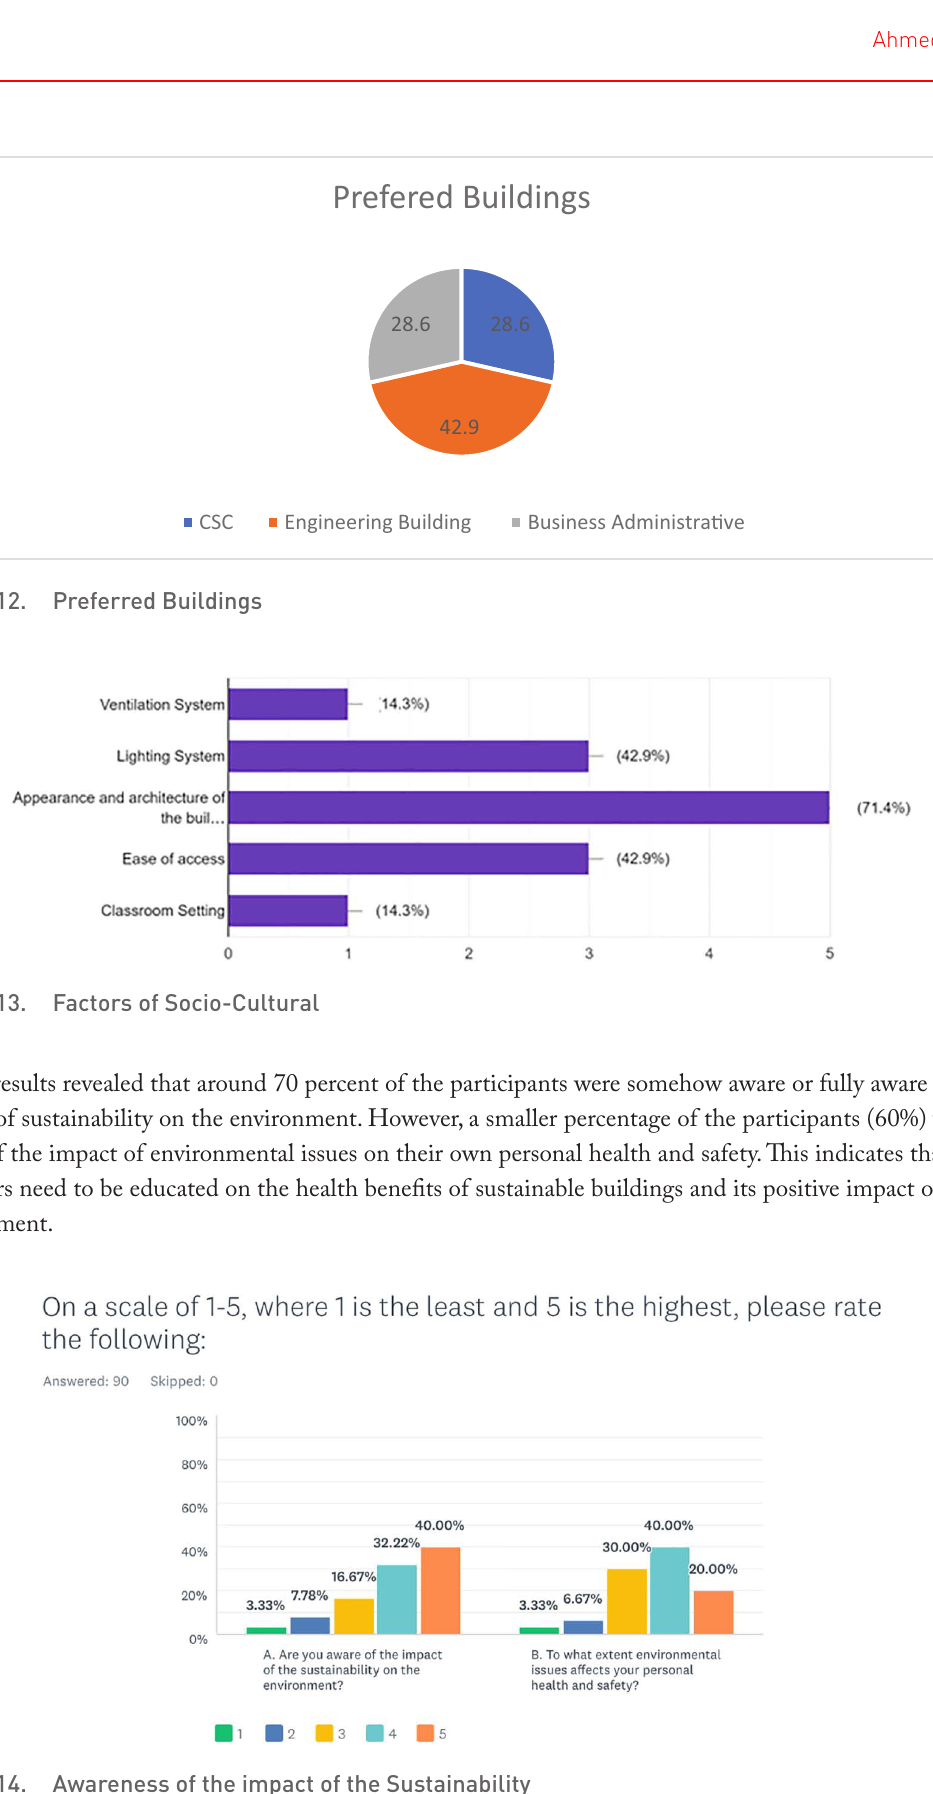
Figure 14. Awareness of the impact of the Sustainability